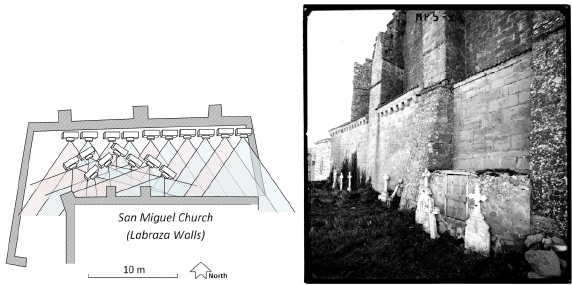
Figure 5. Sketch of the shots (left) and one of the photographs (right) of the graveyard of Labraza. Although not specifically thought for that purpose, the configuration of the shots is rather appropriate for being processed by means of SfM.